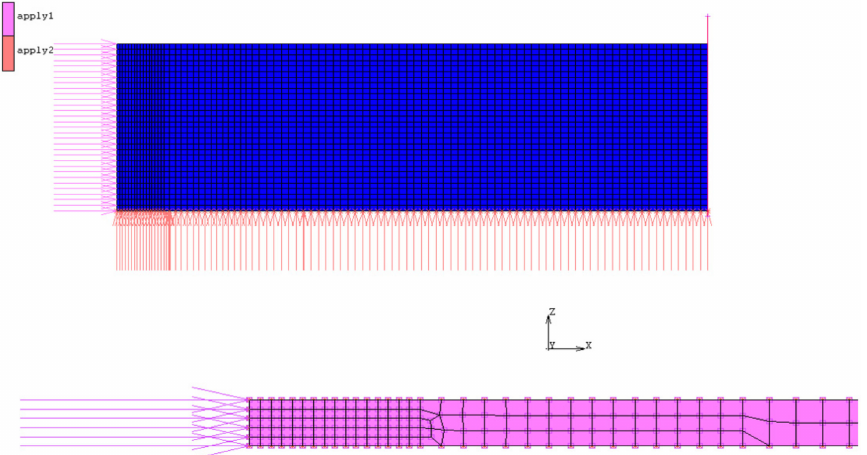
Figure 12. Three dimensional FEM model of base sheet metal.